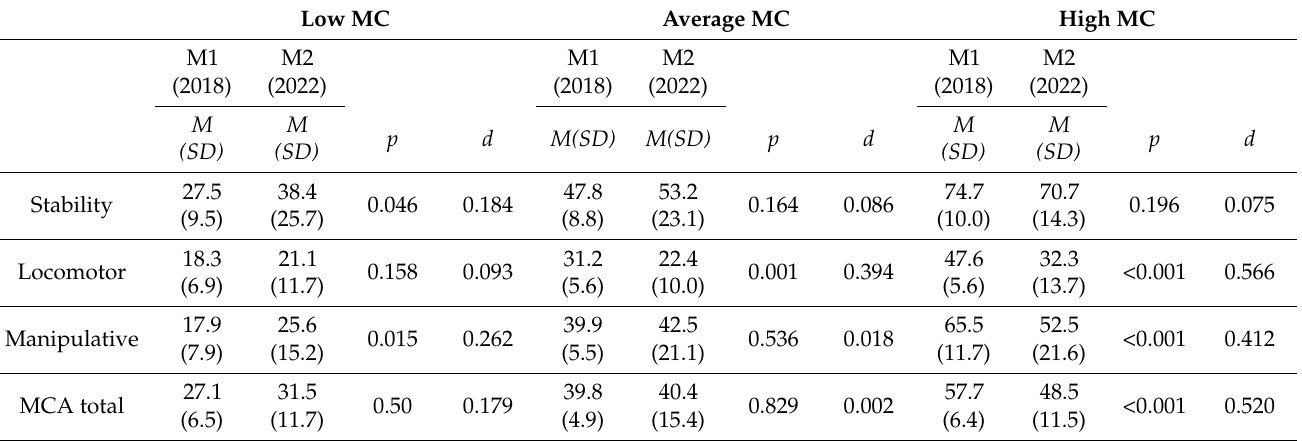
Table 4. MCA percentile values for Subscales and Total scores, by MC level at the baseline (M1), and comparison between M1-2018 and M2-2022 data. Average MC High